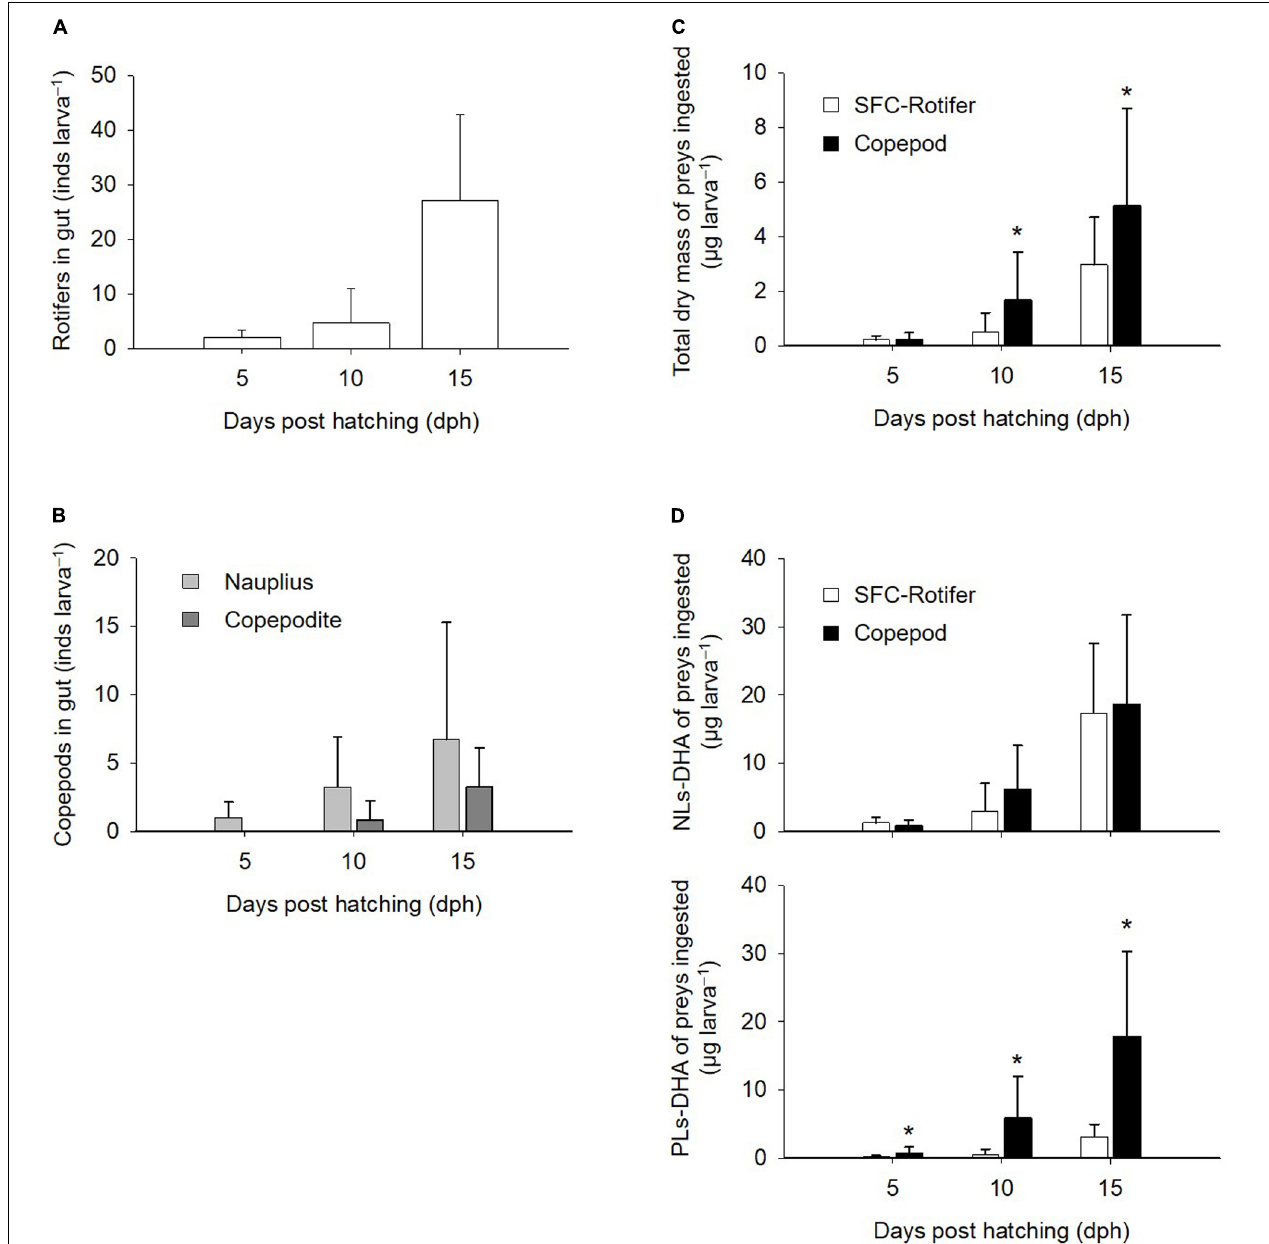
FIGURE 5 | Gut contents of larval Pagrus major based on the number of preys (A,B) , total dry mass (C) , and docosahexaenoic acid (DHA) mass (D) . Ingested mass of DHA is presented for non-polar (NLs-DHA) and polar (PLs-DHA) lipid forms. Values represent means ± standard deviation ( n = 15). Asterisks depict significant differences in dry and DHA masses between rotifers fed docosahexaenoic acid-supplemented Super Fresh Chlorella treatment (SFC-Rotifer) and copepod treatments (Student’s t -test, p <